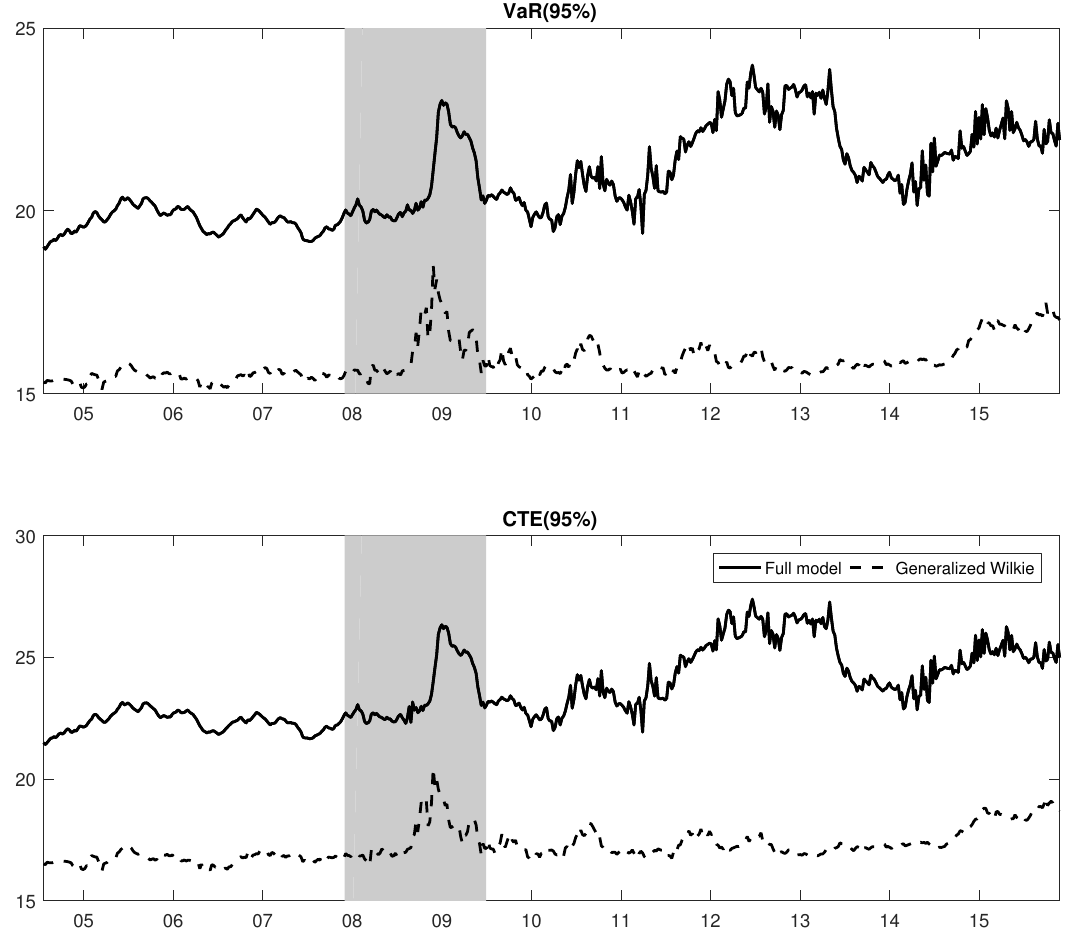
Figure 8. Time series of risk-measures for the life insurer’s future payments, in present value. Values-at-risk and conditional tail expectations were computed under two inflation assumptions: the full model and the generalized Wilkie model. The confidence level is set at 95%. Values are reported in millions. Computations were done using the parameters of Tables 4 and 5. Monte Carlo simulations were used to compute the risk measures. A sample of 10 5 observations were generated to compute each measure. The grey-shaded region highlights the NBER-dated